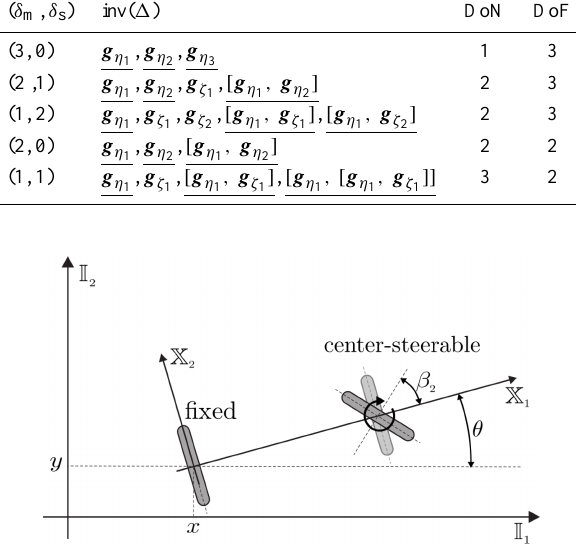
Figure 3. A robot with one fixed and one center-steerable wheel, that would be degenerate in the sense of Campion et al. (1996), although it is still able to reach any posture in the plane.